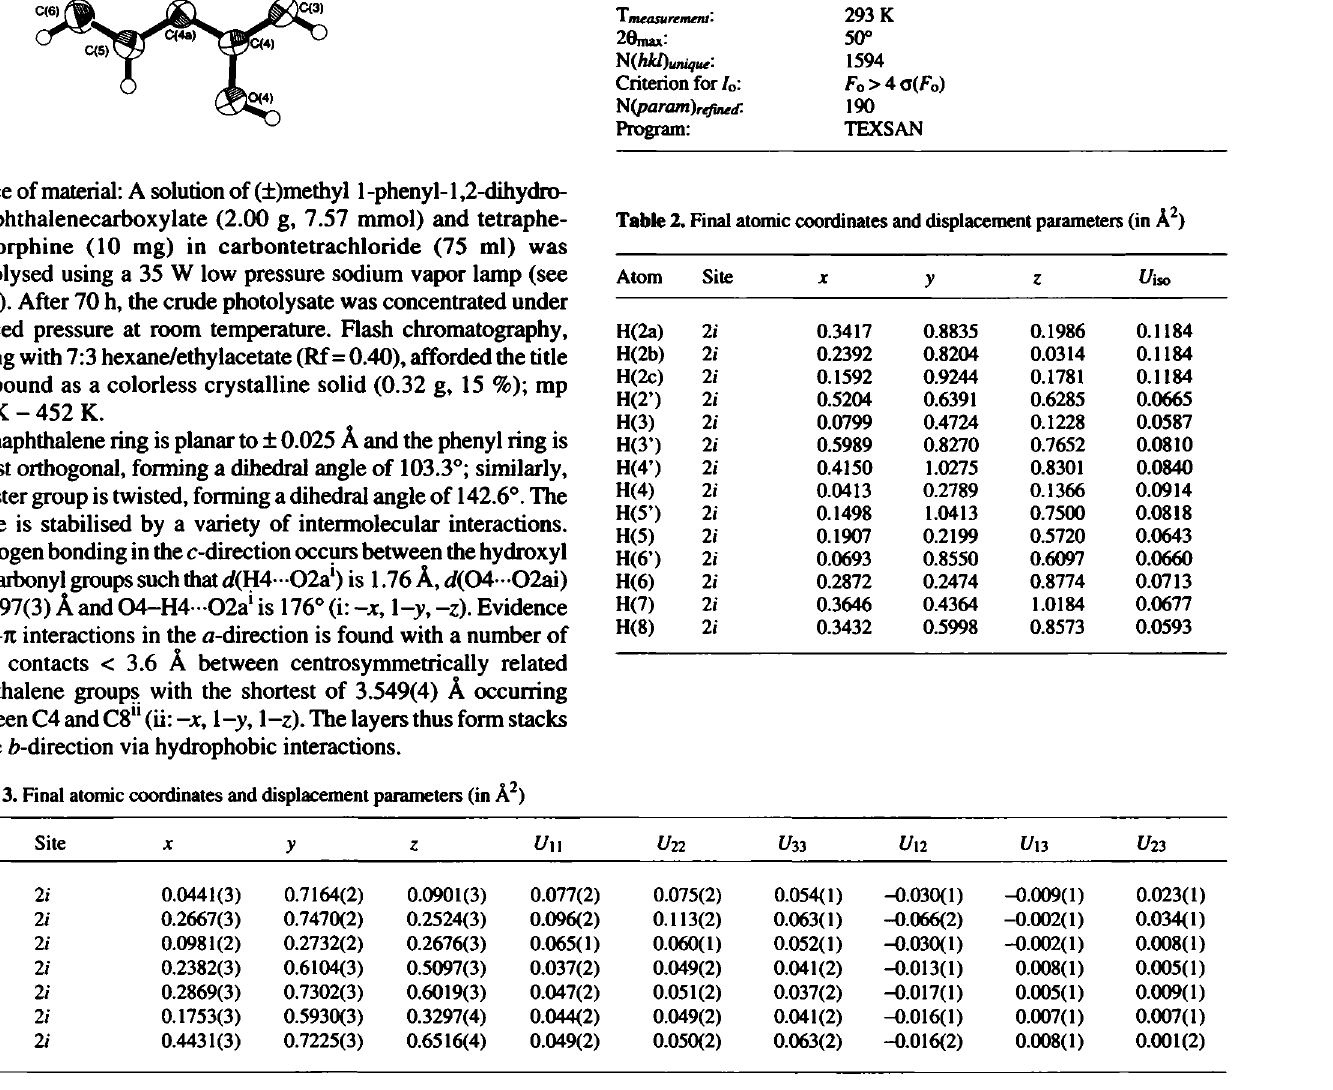
Table 1. Parameters used for the X-ray data collection Crystal: